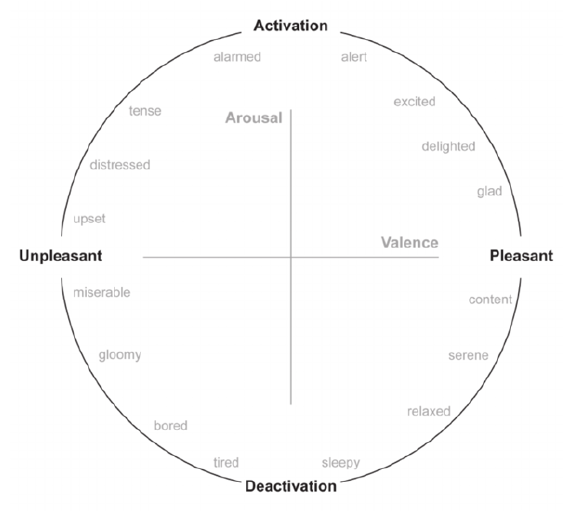
Figure 1. James Russell Arousal-Valence model from